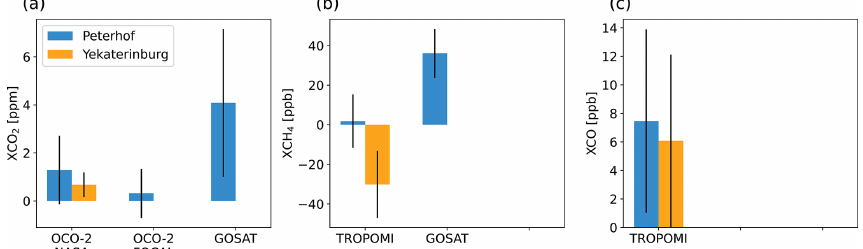
Figure 20. Bar plots of the averaged bias derived from different products with respect to CAMS-COCCON for (a) XCO 2 , (b) XCH 4 and (c) XCO at Peterhof and Yekaterinburg. The error bars represent the standard deviation of the bias.